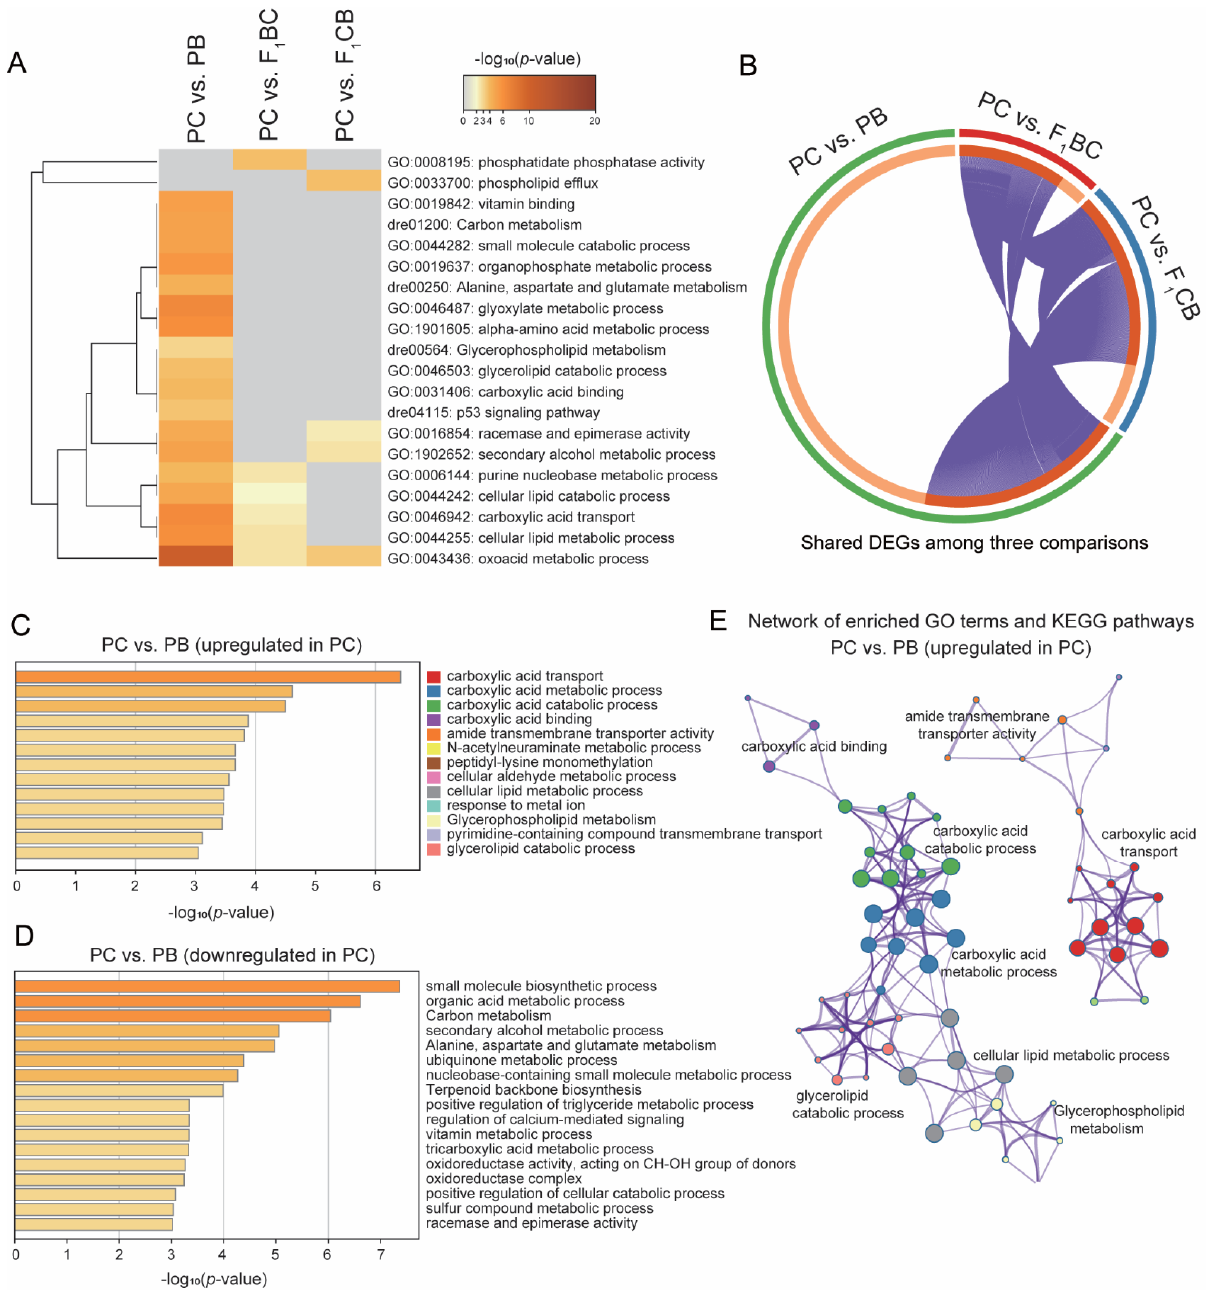
Figure 4. Pathway enrichment analysis of liver Differentially Expressed Genes (DEGs) between channel catfish Ictalurus punctatus parental cross (PC) and three other genetic types (PB: blue catfish I. furcatus parental cross, blue catfish female × channel catfish male hybrids (F 1 BC), and channel catfish female × blue catfish male hybrids (F 1 CB). ( A ) Hierarchical clustering of significant gene on ‐ tology terms shared in at least two of the three comparisons (PC vs. PB, PC vs. F 1 BC, and PC vs. F 1 CB); ( B ) A circular plot of shared DEGs in the three comparisons; ( C , D ) Enriched functional cate ‐ gories for upregulated genes in PC compared to PB ( C ) and downregulated genes in PC compared to PB ( D ); Enrichment scores measured by − log 10 ( p ‐ value) were shown on the x ‐ axis; ( E ) A plot of enriched term network for upregulated genes in PC. GO terms were represented by the same color dots as in ( C ), and the interconnectivity was represented by the edges.